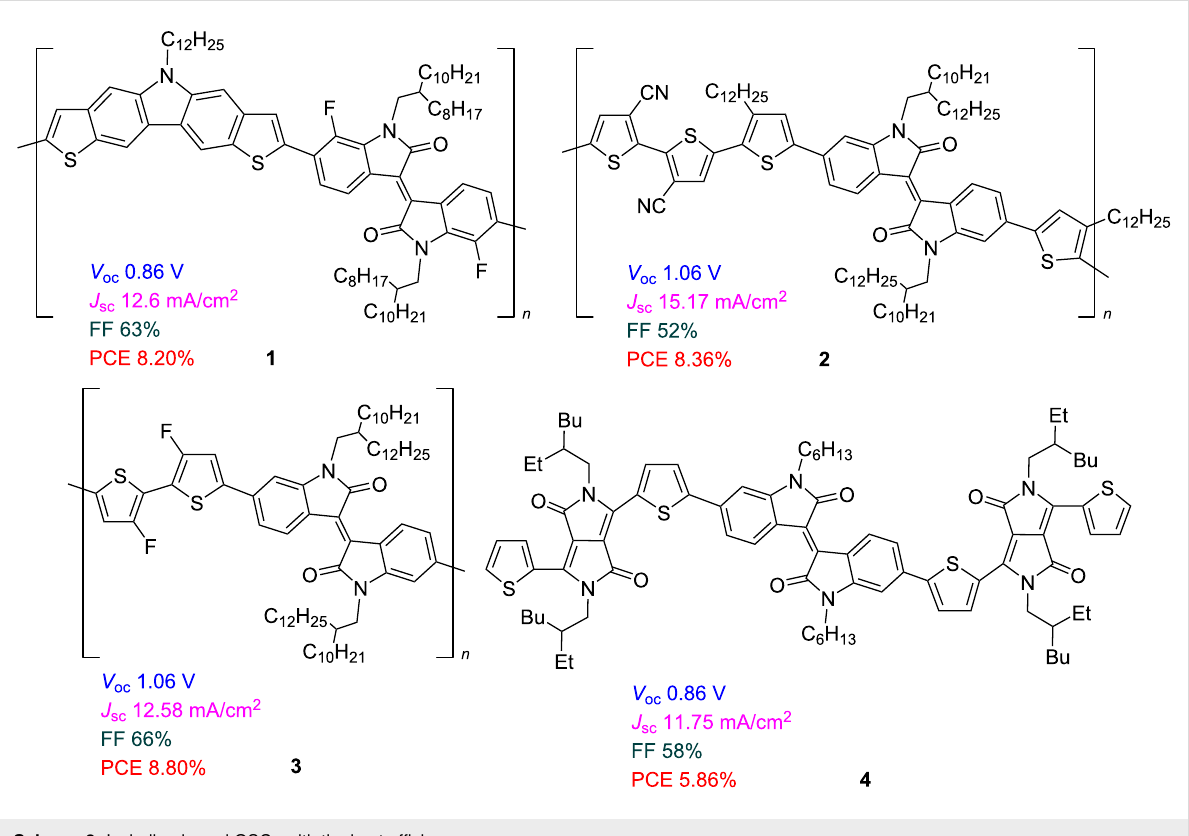
Scheme 2: Isoindigo-based OSCs with the best efficiency.